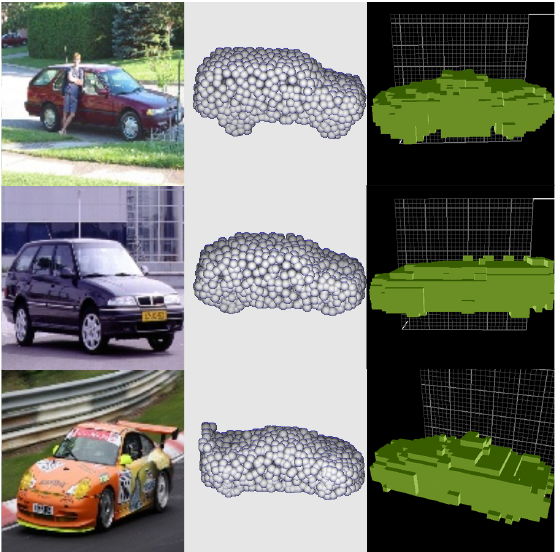
Figure 10. Car images from ObjectNet3D [30]. The orders from left to right: original images, the results of PCCNet and OGN